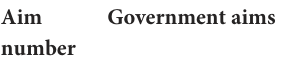
TABLE 1 The government aims and standards for the HAF Programme